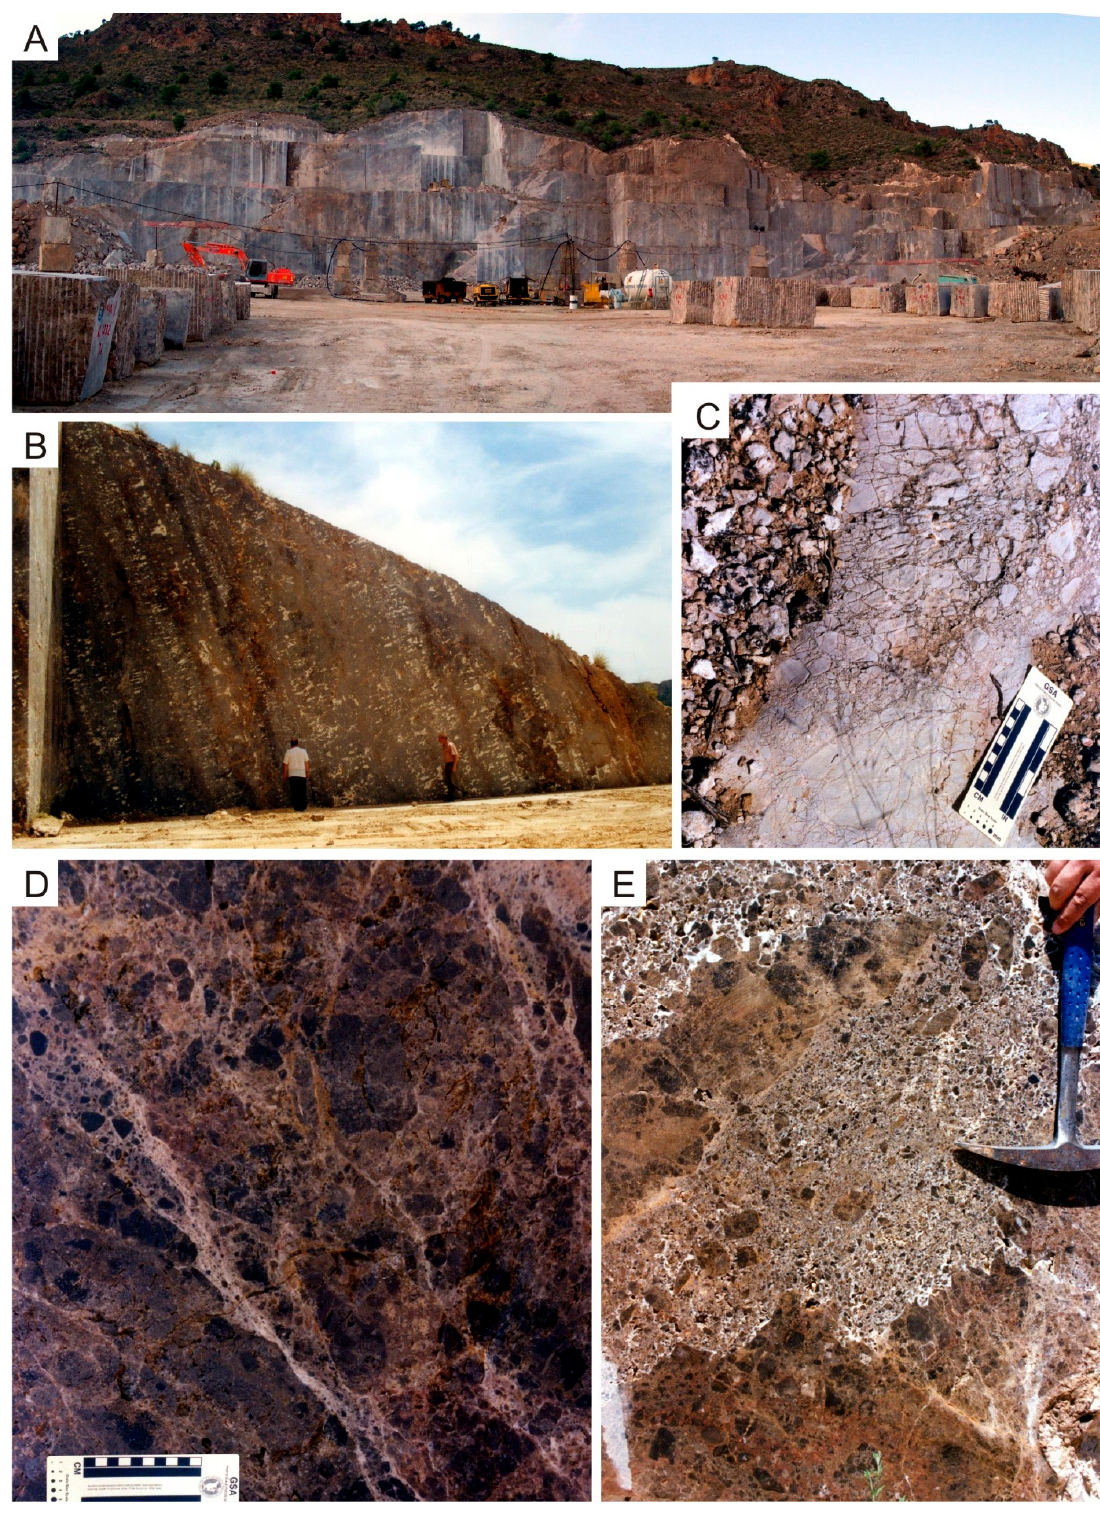
Figure 3. Field images of the main outcrops and breccia types recognised in the study area. ( A ) General view of Marrón Emperador quarry at Sierra de la Magdalena (Yecla, Murcia) (Y section, central sector). ( B ) General view of Marrón Emperador quarry at Sierra de Cingla (Murcia) (JIM section, southeast sector). ( C ) Crackle breccia (Sierra del Príncipe, Murcia) (SP section, central sector). ( D ) Mosaic breccia (La Encina, Alicante) (EN section, northeast sector). ( E ) Chaotic breccia (La Encina, Alicante) (EN section, northeast sector).